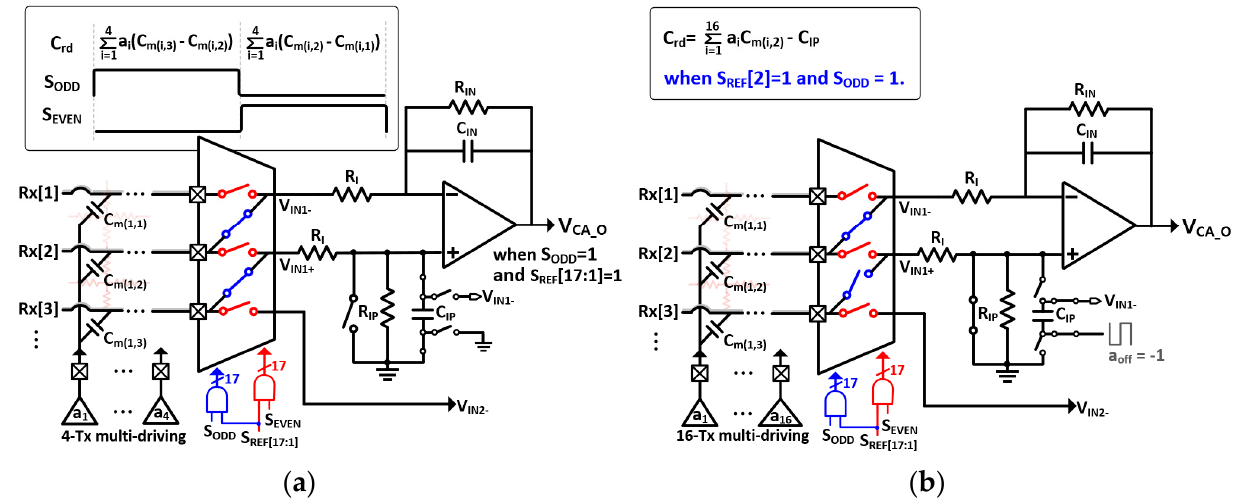
Figure 8. Proposed reconfigurable CA for both ( a ) sensing of ∆ C m s and ( b ) C ref s.